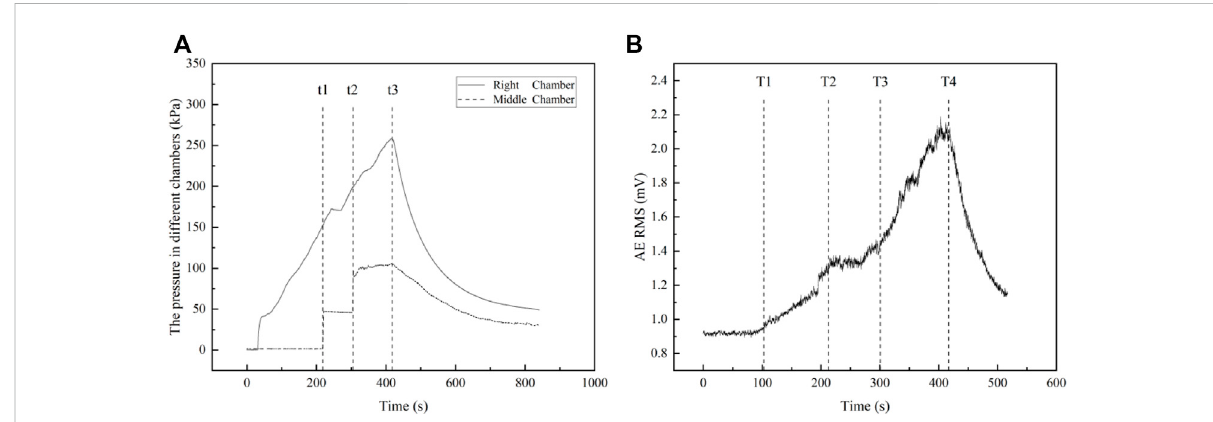
FIGURE 4 (A) Pressure curves; (B) AE RMS curves.